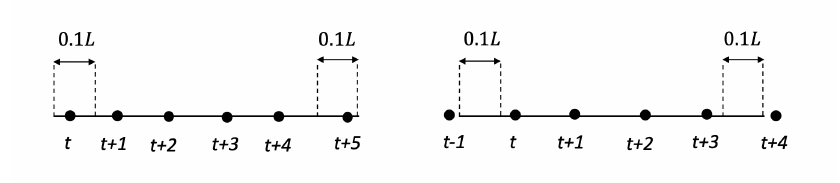
Figure 2. Valid GPS trace ( left ) and GPS trace with a few observations not respecting C2 ( right ).